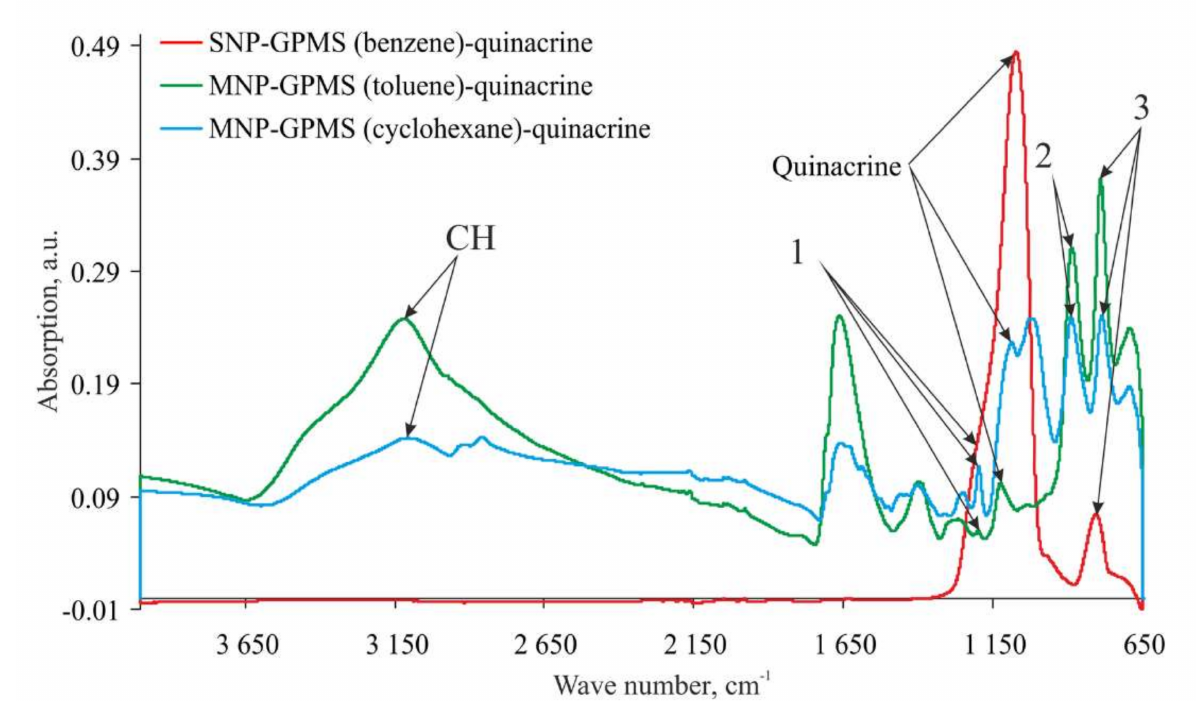
Figure 5. IR spectra of the GPMS-modified nanoparticles with immobilized quinacrine. All three samples show a strong band corresponding to the wavenumber 1130 cm − 1